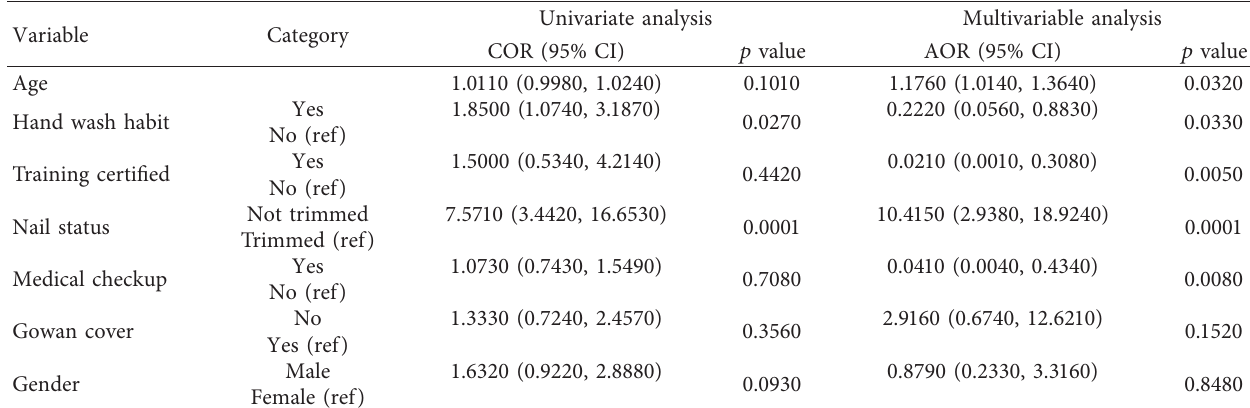
Table 2: Binary logistic regression analysis of intestinal parasitic infections and corresponding factors among food handlers at Mettu town food establishment